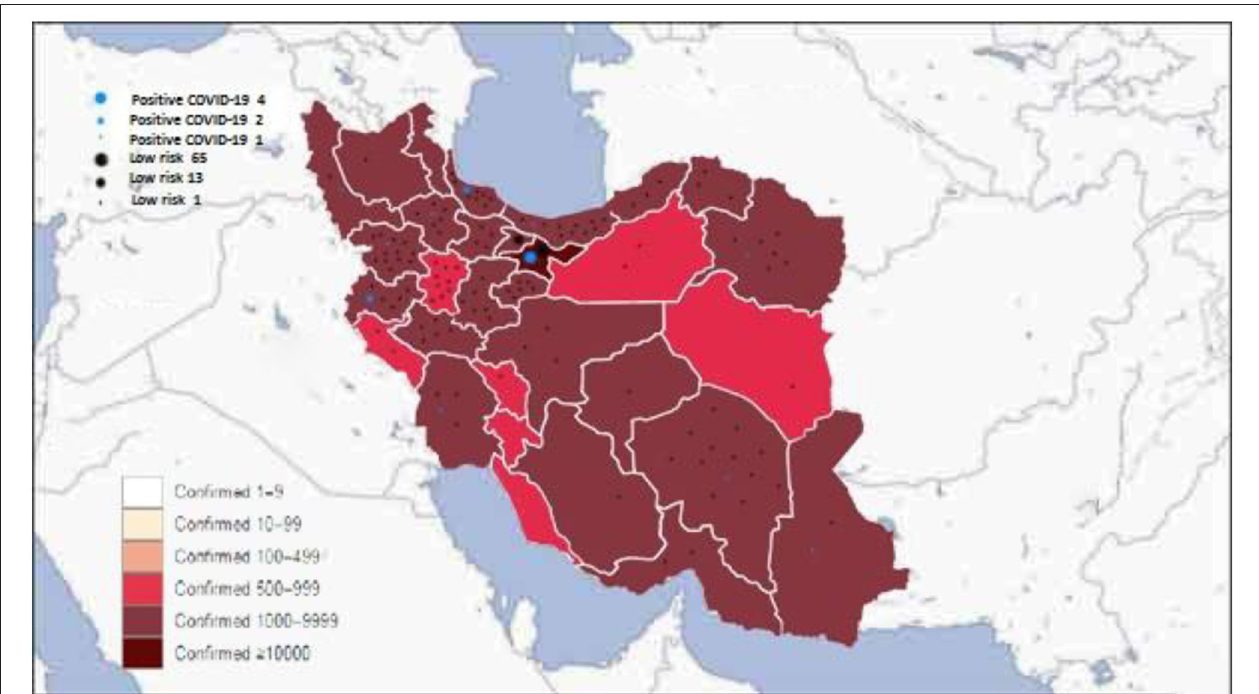
FIGURE 1 | Distribution of the confirmed coronavirus disease 2019 (COVID-19) in Iran in each province and our patients’ COVID-19 status.